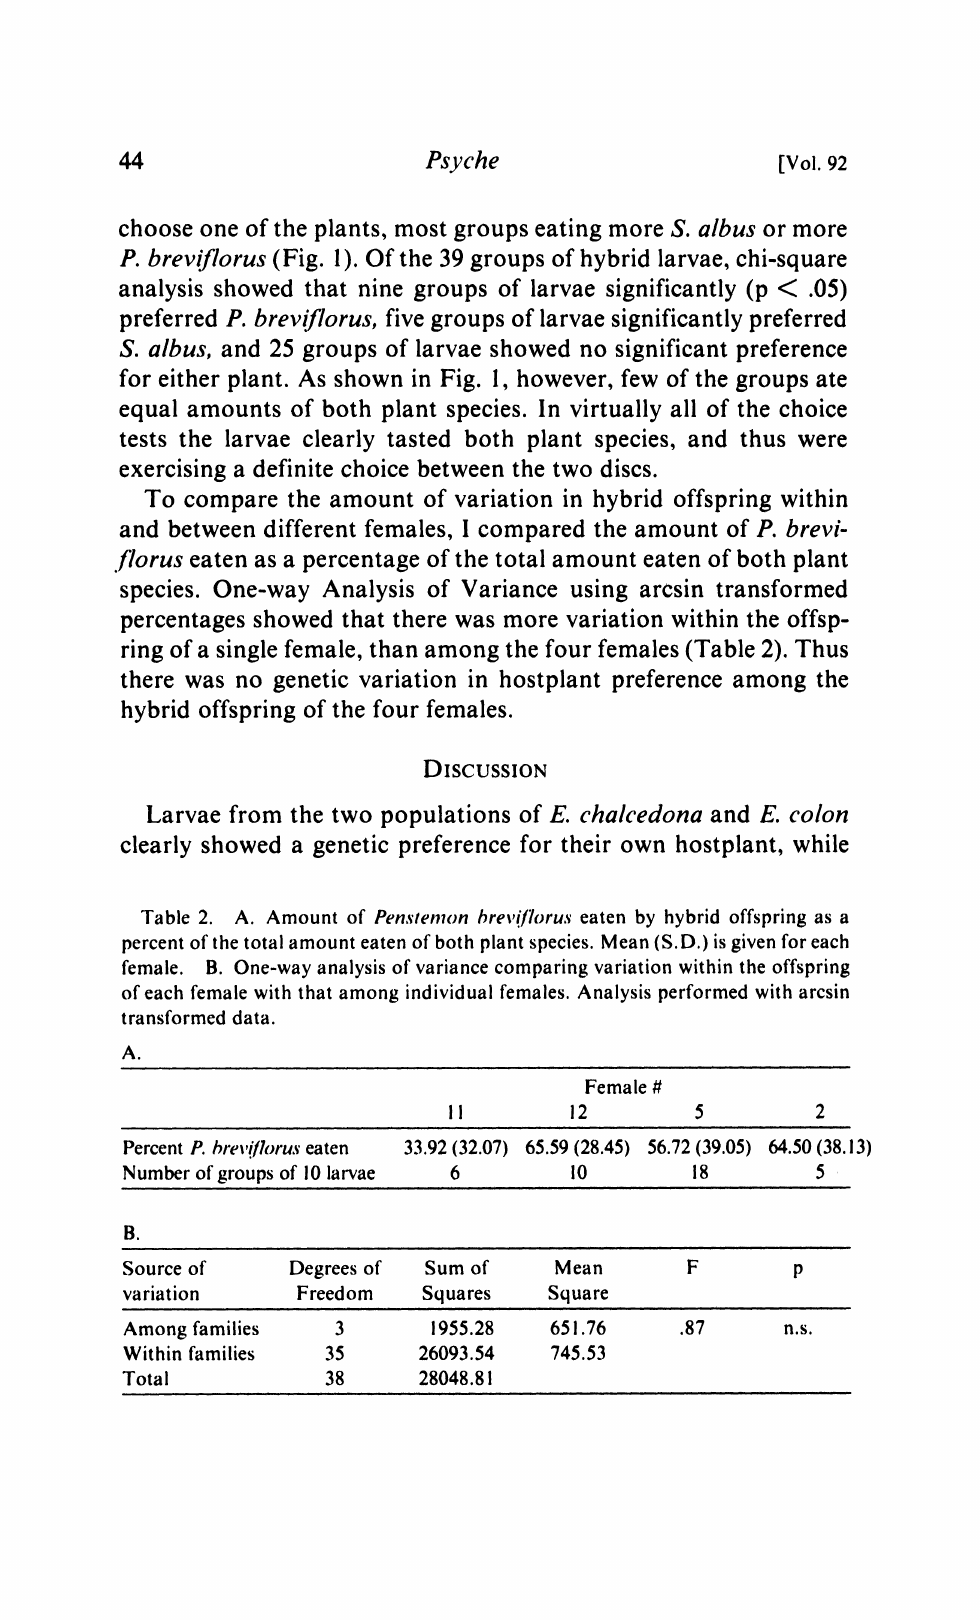
Table 2. A. Amount of Penstemon hrev([’lorus eaten by hybrid offspring as a percent of the total amount eaten of both plant species. Mean (S.D.) is given for each female. B. One-way analysis of variance comparing variation within the offspring of each female with that among individual females. Analysis performed with arcsin transformed